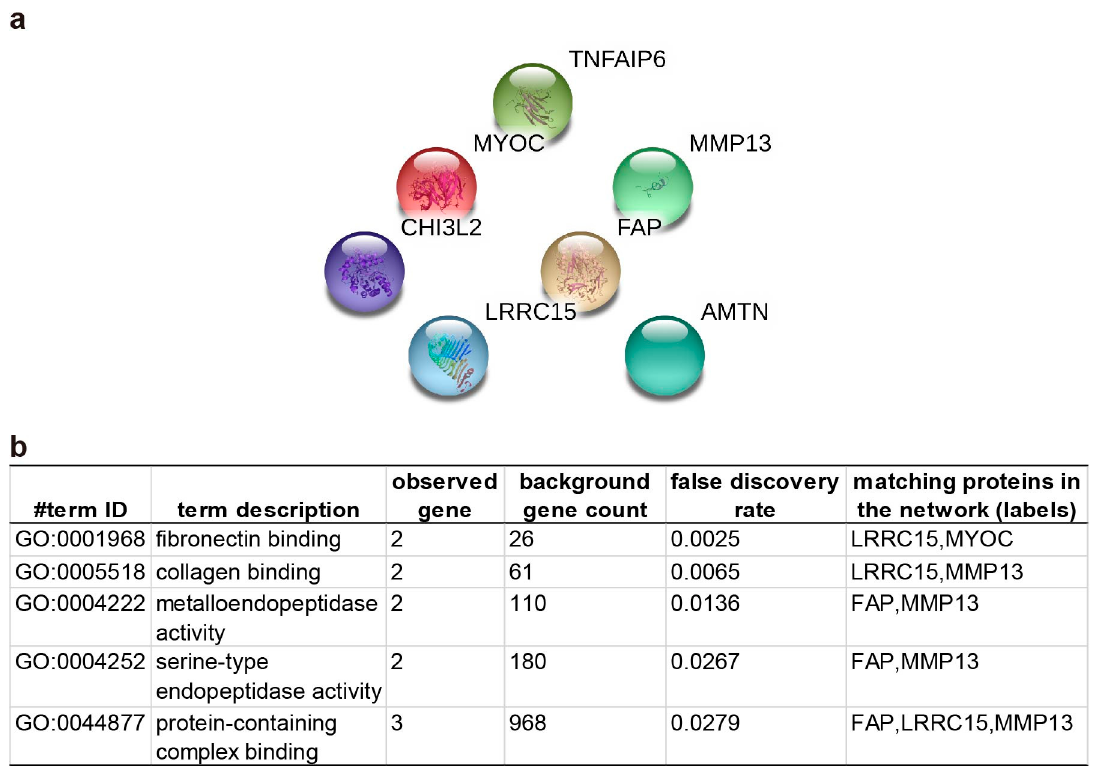
Figure 6. The clustering results from the STRING database by inputting 7 extracellular matrix related genes. ( a ) the diagram generated from the STRING data based to demonstrate the potential interactions. ( b )The list contains identified pathways with a false discovery rate less than 0.05. MYOC: Myocilin , AMTN: Amelotin , CHI3L2: Chitinase-3-like protein 2 , FAP: Fibroblast activation protein alpha , LRRC15: Leucine-rich repeat-containing protein 15 , MMP13: Matrix metallopeptidase-13 , TNFAIP6: Tumor necrosis factor-inducible gene 6 protein.